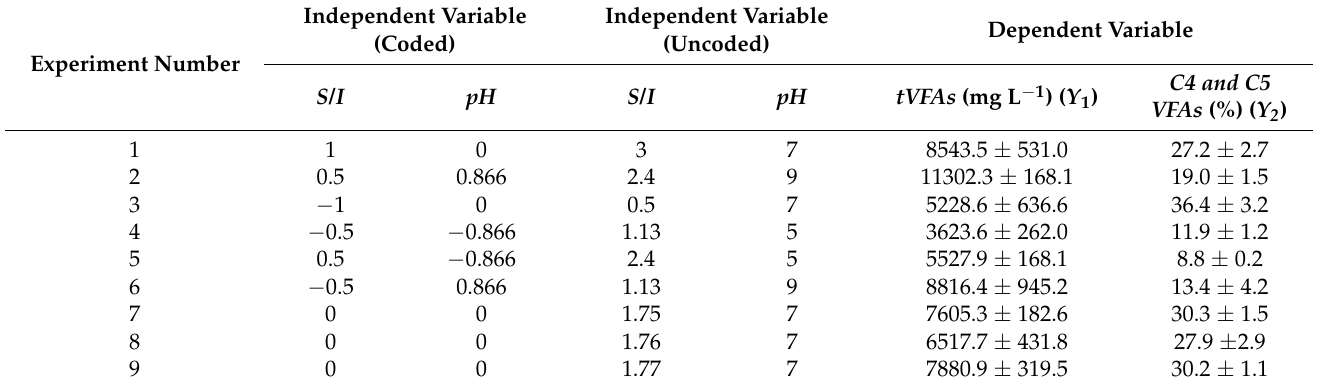
Table 1. Doehlert design matrix was used for the optimization of the independent variables pH and S/I